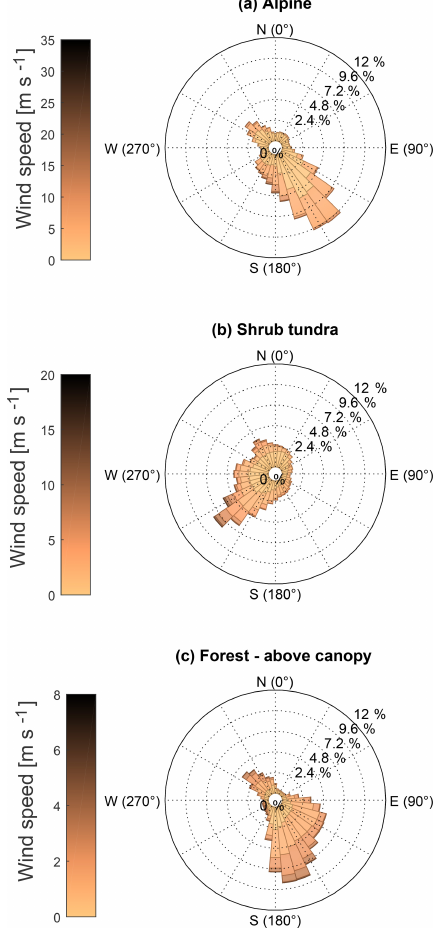
Figure 4. Wind speed and direction at the three sites in Wolf Creek Research Basin, averaged over the period of 1993–2014.